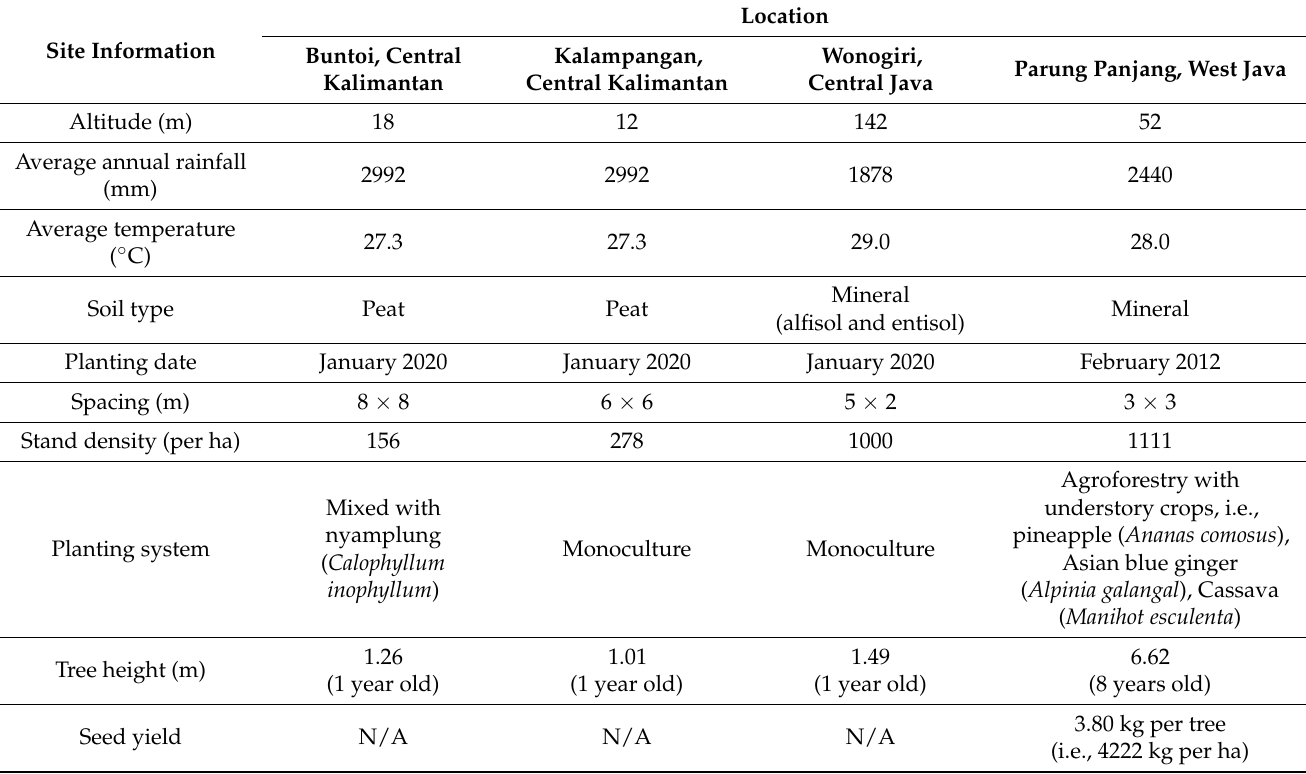
Table A1. Performance and management of pongamia in four different locations in